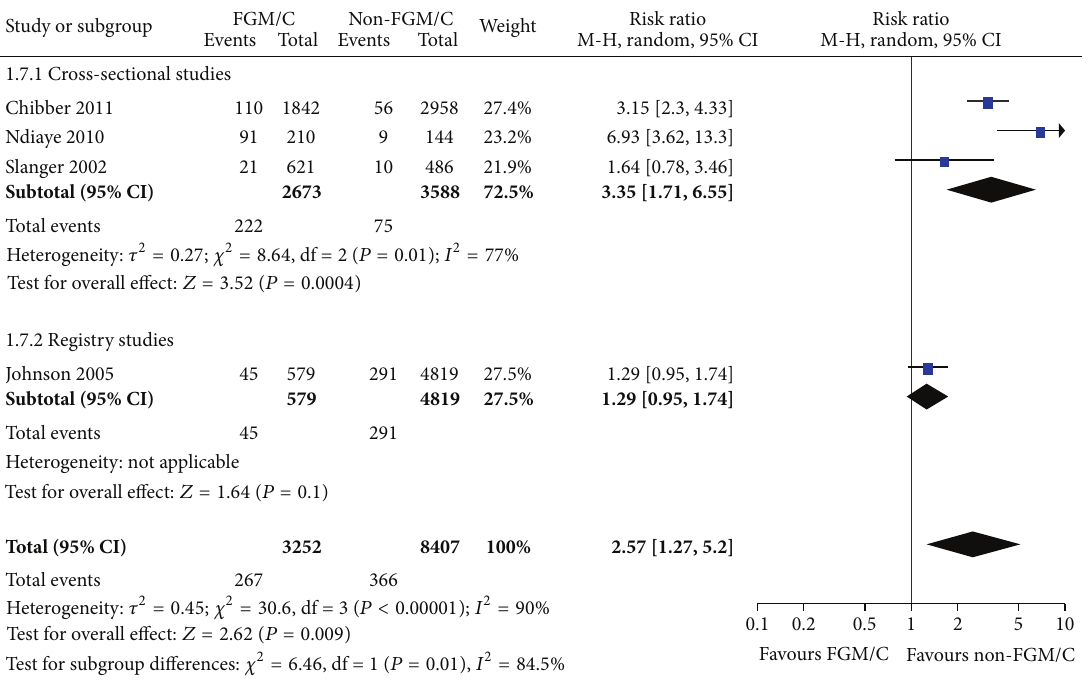
Figure 8: Forest plot, difficult